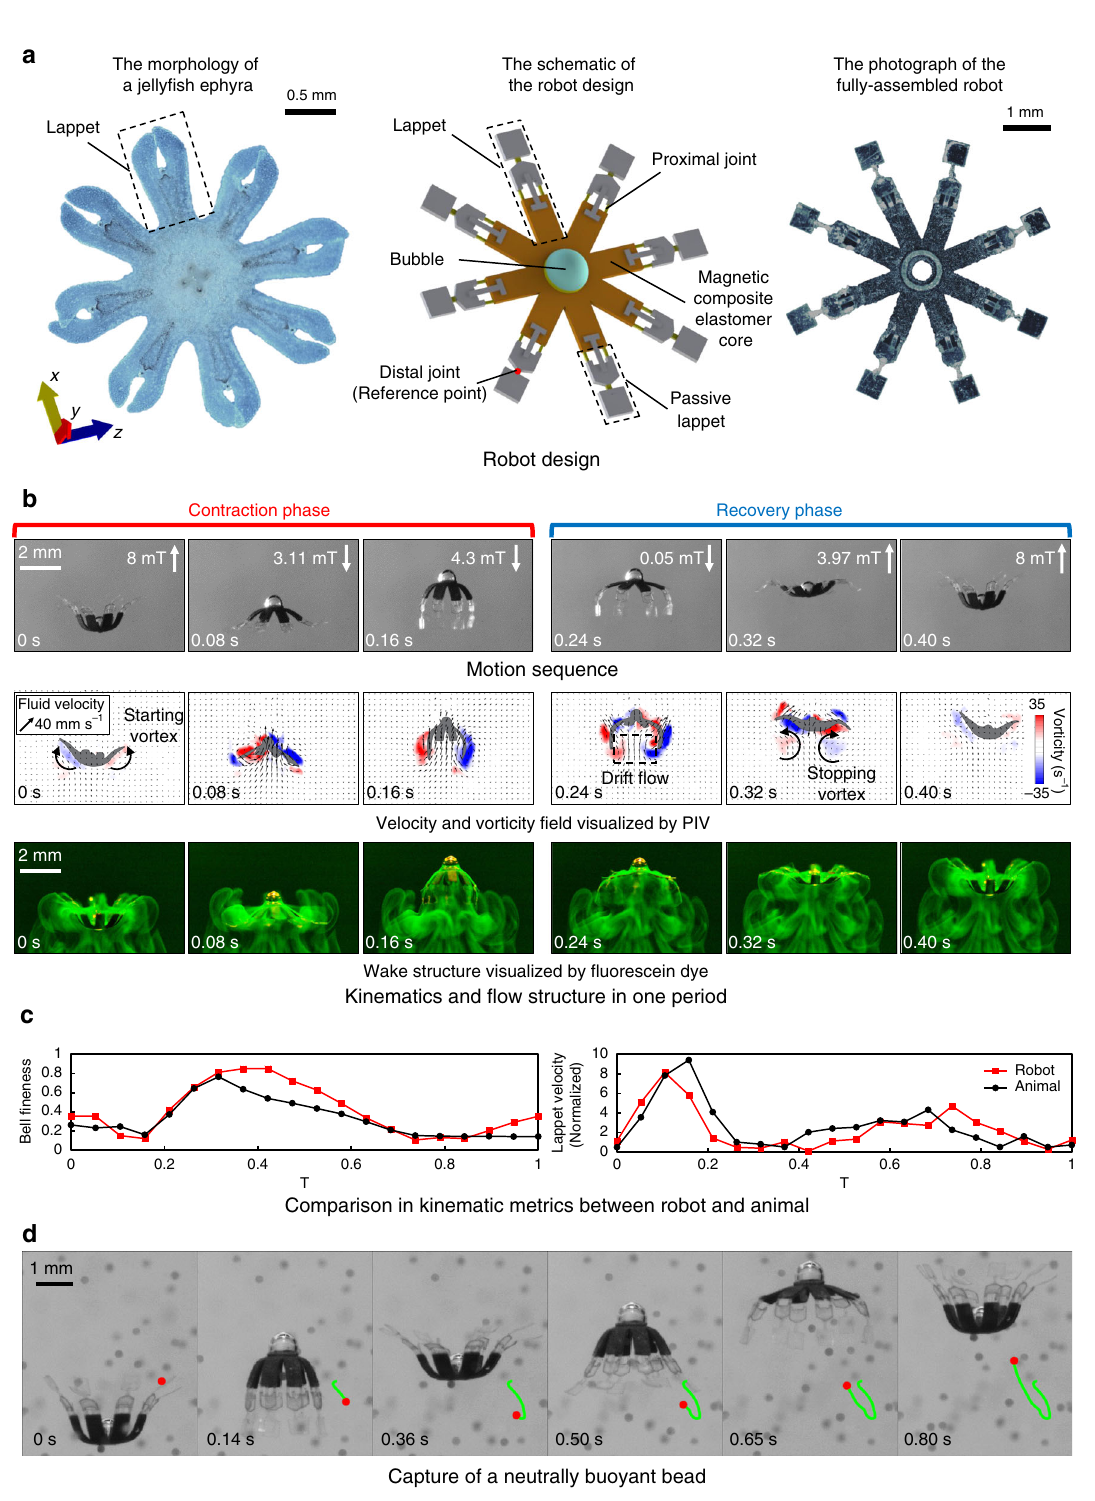
Fig. 1 Design and swimming behavior of the jelly fi sh-inspired swimming soft millirobot. a Comparison in morphology. The newly budded scyphomedusae ephyra ( Aurelia aurita ) possesses deep clefts between two adjacent lappets. The design of the jelly fi sh-inspired soft millirobot captures such feature. The photo of the real animal is taken in a pet store and the animal ’ s care is in accordance with the institutional guidelines. b Kinematics and fl ow structures achieved by Mode A. The motion sequence, the velocity and vorticity fi elds, and the wake structures visualized by the fl uorescein dye are all in one cycle. The three experiments are from three different trials using robots with the same design and kinematics. c Comparison of the robot and animal in two kinematic metrics: bell fi neness and lappet velocity. The biological data is reproduced with permission from Feitl et al. 28 ; permission is conveyed through Copyright Clearance Center, Inc. d Video snapshots of capturing a neutrally buoyant bead using the fl uid fl ow around the robot ’ s